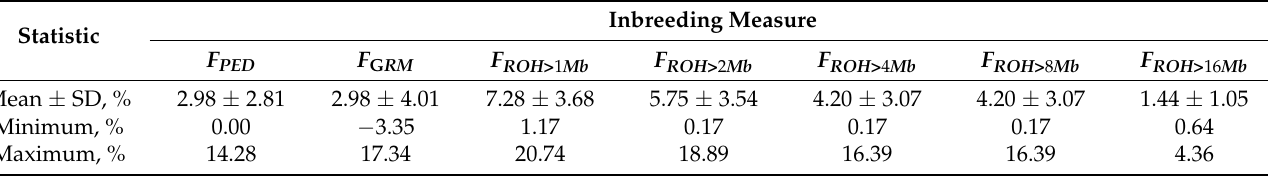
Ferencakovic et al. [47] reported an F ROH value of 9.0 ± 2.2% for Austrian Simmental bulls, Simmental, 7.2 ± 3.2% for Limousin, and 5.7 ± 2.6% for Polish Red